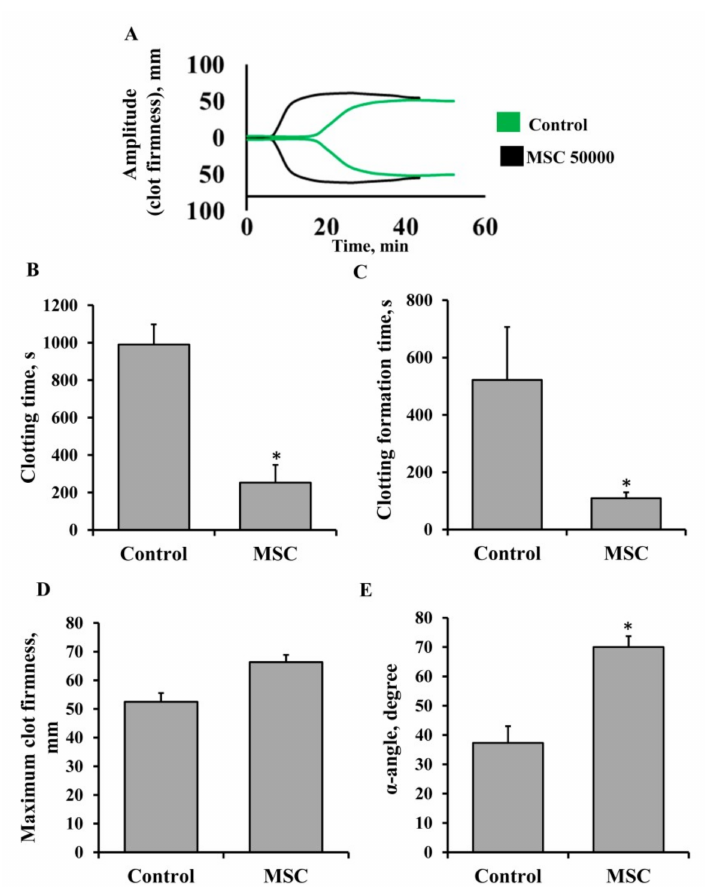
Figure 7. Procoagulant effects of MSCs in the whole blood of patients treated with heparin. ( A ) Representative thromboelastometry diagrams of clotting in whole blood from donors show a change in the clot elasticity over time depending on the addition of MSC to the sample. ( B ) Clotting time, ( C ) clot formation time, ( D ) maximum clot firmness, and ( E ) α -angle assayed by the NATEM test. MSCs were resuspended in 1 mL of freshly obtained blood at a concentration of 5 × 10 4 cells per mL, then 300 µ L of the suspension was sampled for analysis. Blood from seven patients was used, and each blood sample was incubated with MSCs from three different umbilical cord samples. * p < 0.05, Student’s t